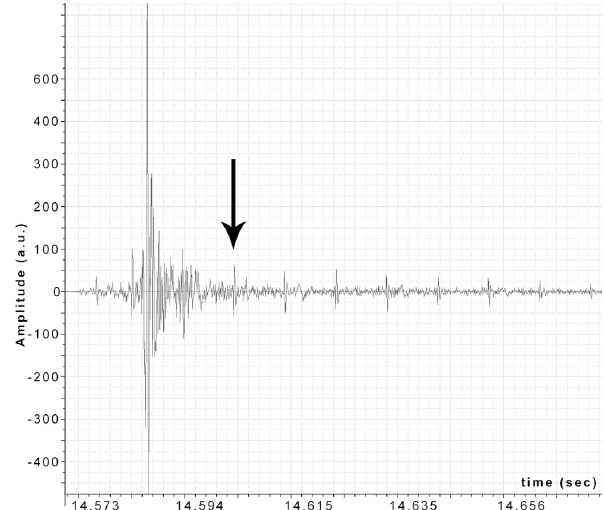
Figure 6. An EM signal registered during gradual loading of a gra- nodiorite sample. The arrow points to one of the weak peaks that accompany the main impulse that is the strongest